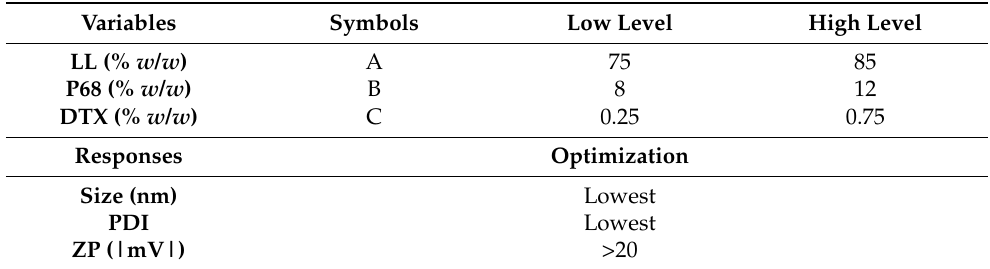
Table 4. Experimental variables, levels and responses analyzed in the 2 3 factorial